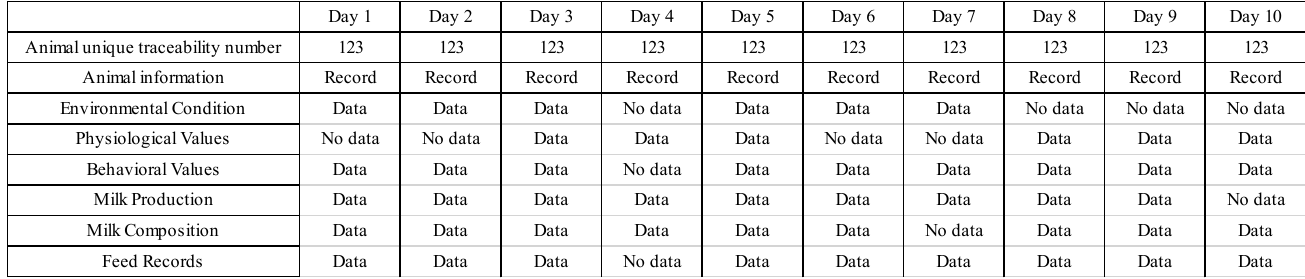
Figure 1. The basic format of the data-mining hub in which the cleaned and harmonized data were loaded. The figure illustrates the scheme of data collection and integration format used in the study based on the report of [17] .